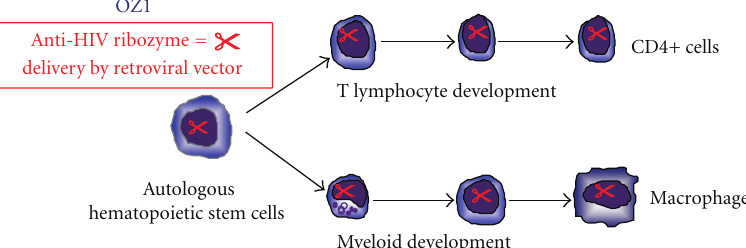
Figure 1: The figure shows the concept of introducing an anti-HIV gene (in this case a ribozyme) into hematopoietic stem cells. As these cells mature and di ff erentiate into T lymphocytes and myeloid cells, the anti-HIV gene is expressed in these cells potentially providing an anti-HIV e ff ect in cells susceptible to HIV.